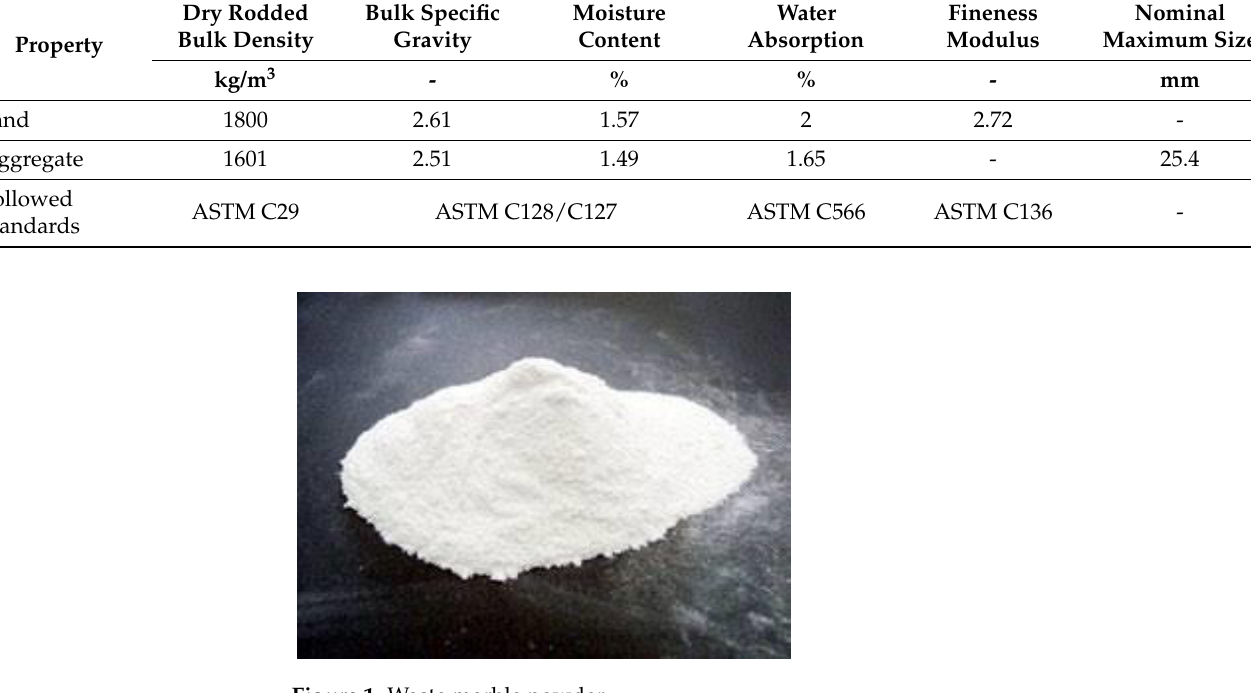
Figure 1. Waste marble powder Table 2. Chemical composition of cement and marble powder.